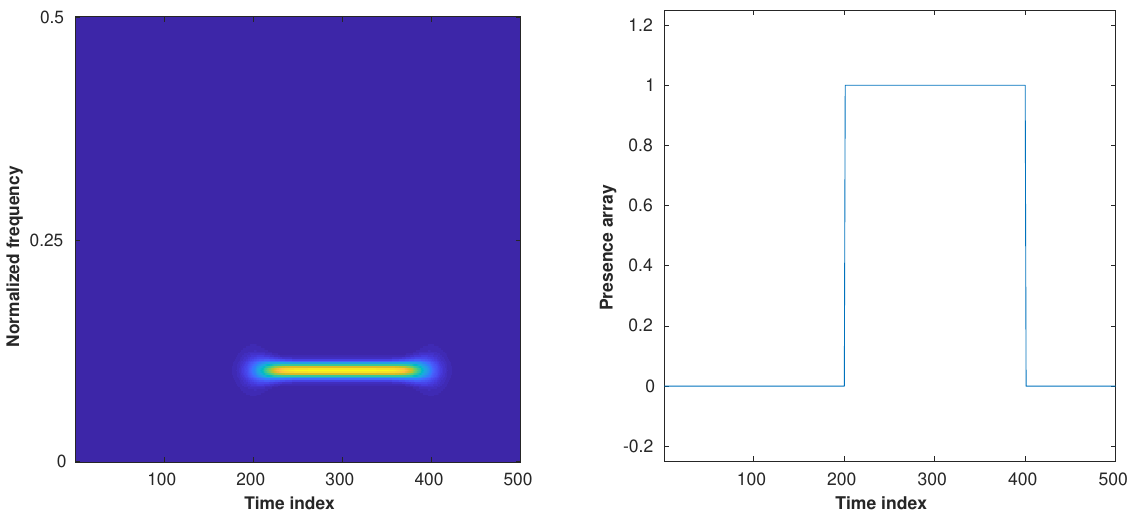
Figure 8. Left : Spectrogram of a noiseless monocomponent signal whose frequency is not null in time indices [ 200,400 ] . Right : Ground truth binary detection indicating where the signal amplitude is